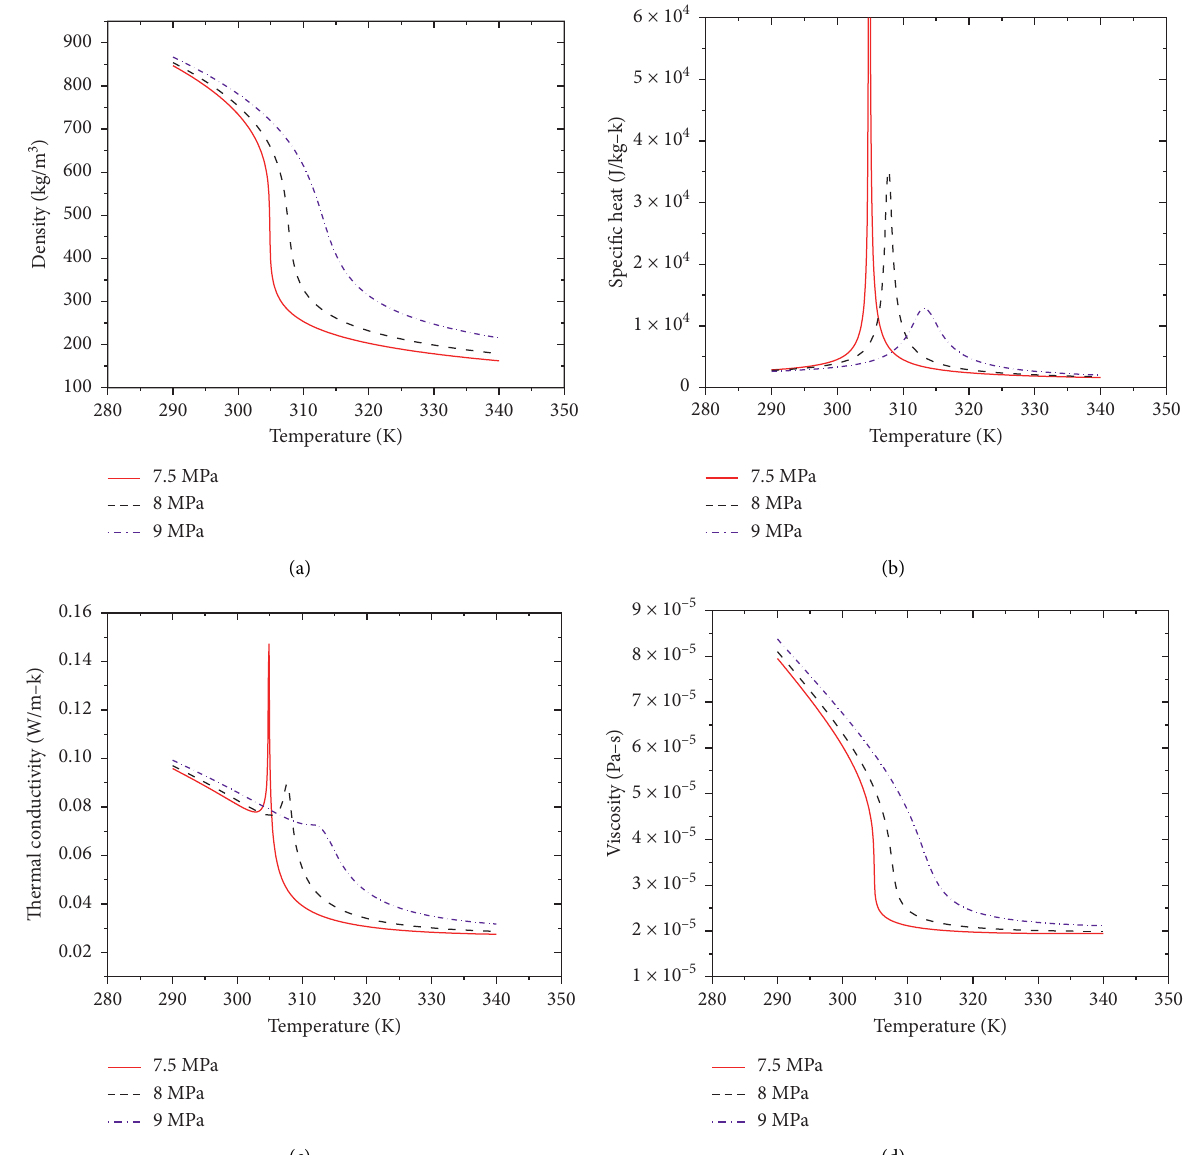
Figure 1: Thermophysical properties of CO